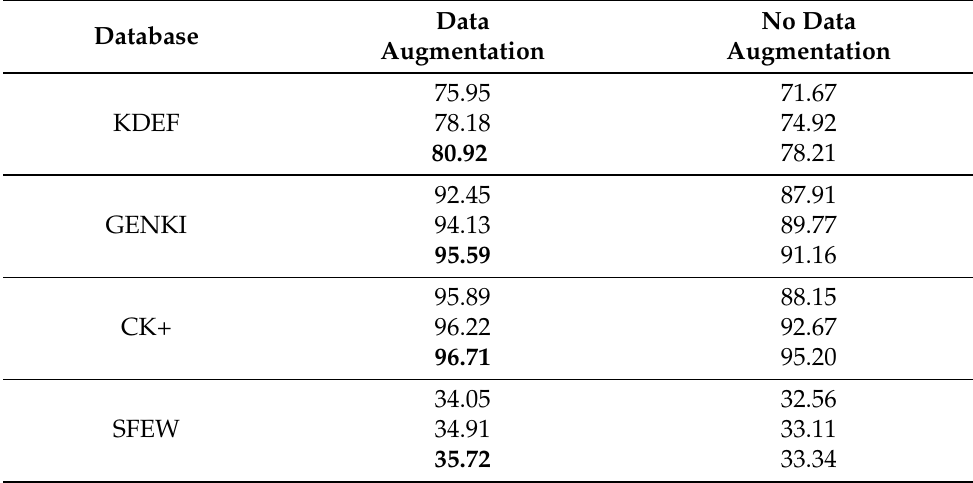
Table 5. Effect of the progressive image resizing on the performance of the proposed FERS where the first, second, and third row for each database shows the accuracy in percentage using CNN